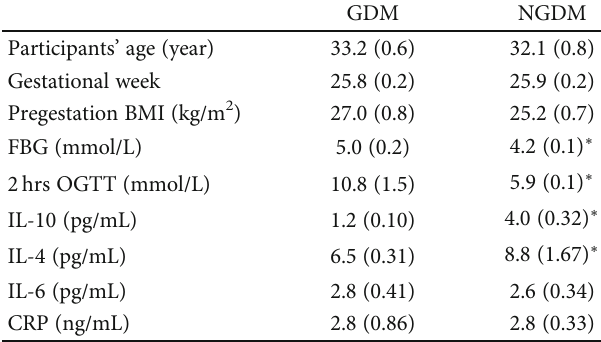
Table 1: Demographic characteristics of subjects, mean